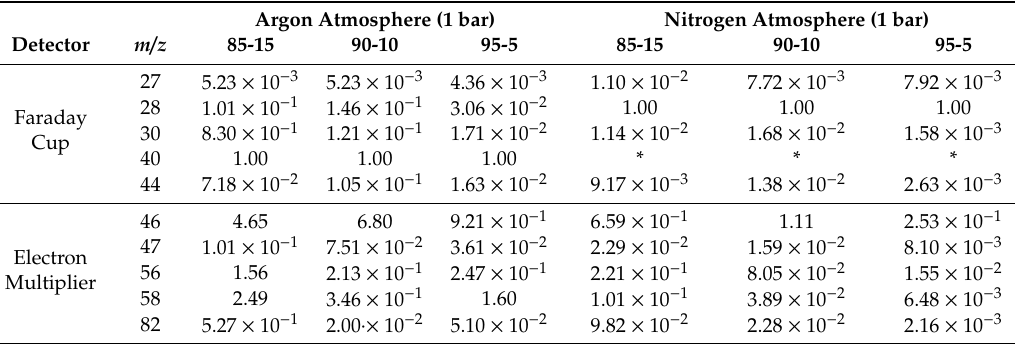
Figure 1. Pyrolysis species followed with MS. Table 1. Pyrolysis species relative intensities regarding the gas nature.